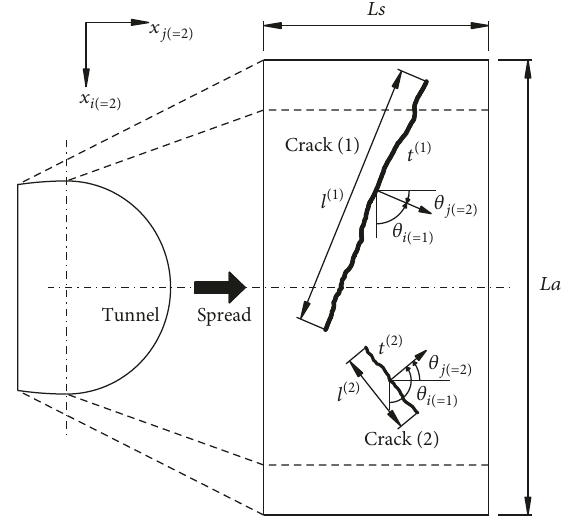
Figure 1: Conceptual diagram of tunnel lining crack index (TCI).